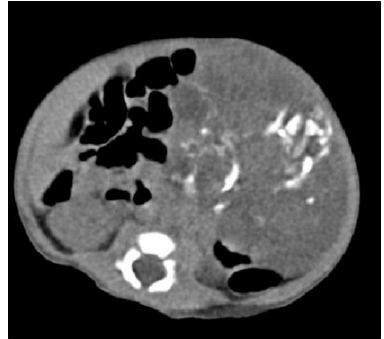
Figure 1: Computerized Tomography ima- ging showing a heterogenous mass with solid and cystic components along with internal